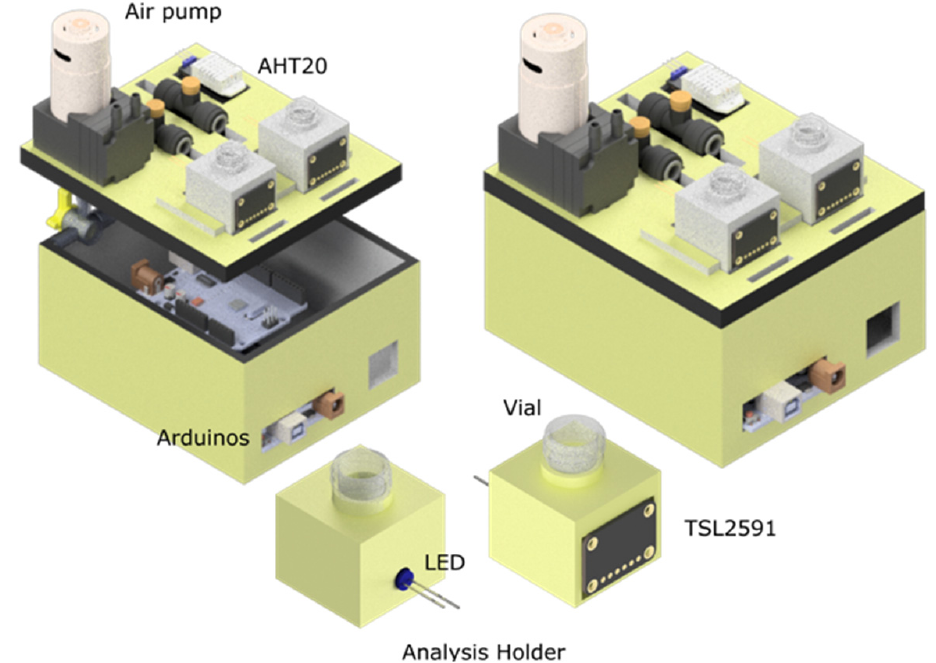
Figure 2. 3D model of the analytical platform for air quality monitoring. The LEDs were shined using a resistor-based circuitry (R = 300 ohm) attached to the Arduino, providing a constant current of 17 mA. The current generated by the sensors’ photodiodes is converted into a digital output by the integrated analogic-to-digital (ADC) circuitry representing the light intensity at the visible spectra range. The devices were attached and controlled by two Arduino Uno boards using the library provided by the man- ufacturer. The detector’s operational settings under optimized conditions were integration time of 200 ms and 1 × gain (low). Additionally, the light sensors can continuously send the signals’ values to an Android app (Bluetooth Terminal HC-05, MightyIT, London, UK) or a laptop via Bluetooth. The complete electric circuit scheme is demonstrated in Figure